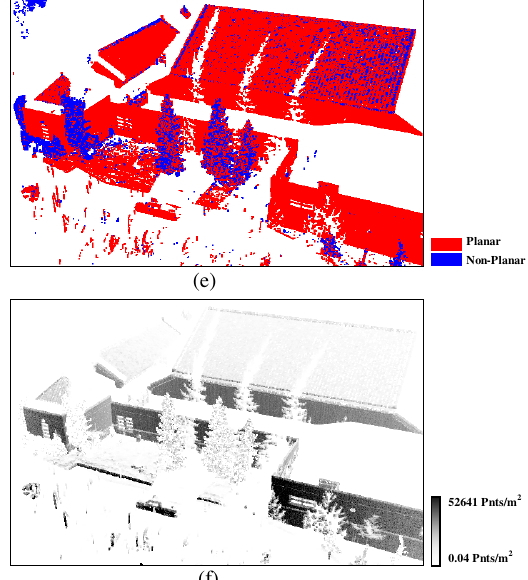
Figure 9. Terrestrial LiDAR dataset: (a) original LiDAR data, (b) generated point density map using the approximate method, (c) planarity check result using the eigen-value analysis relative to the point in question, (d) generated point density map based on eigen-value analysis relative to the point in question, (e) planarity check result using the adaptive cylinder method, and (f) generated point density map based on adaptive cylinder